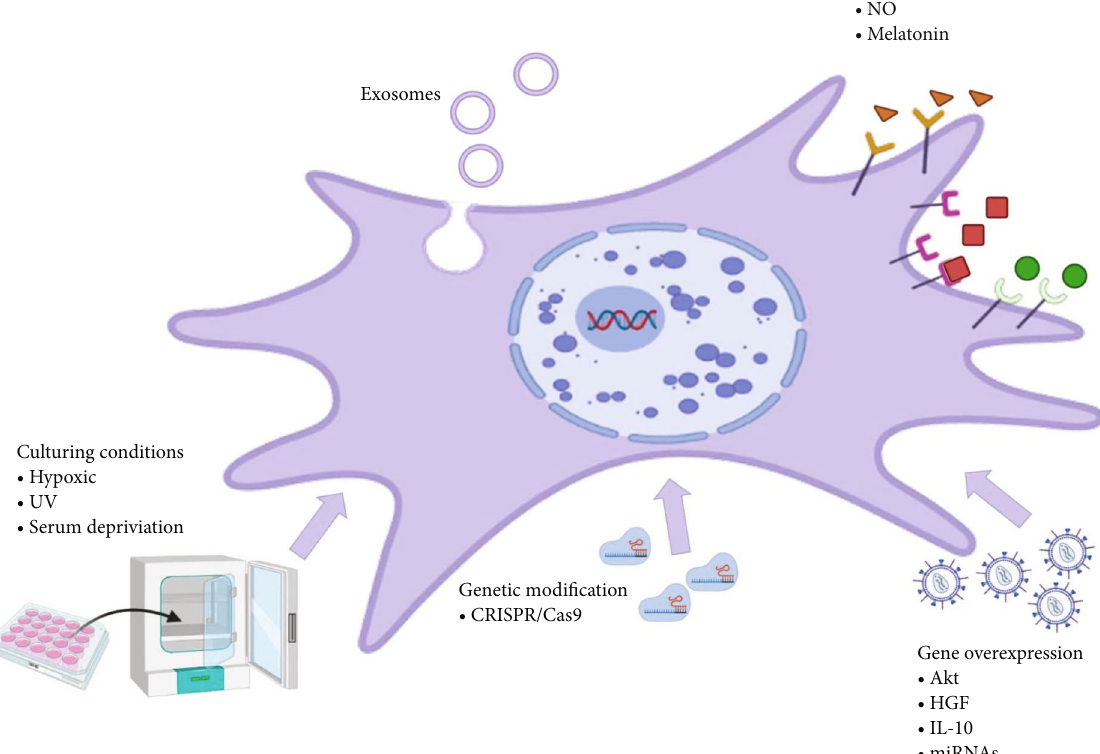
Figure 6: Preconditioning approaches to enhance the secretion and therapeutic e ffi cacy of exosomes. The yield of secretome can be increased by preconditioning strategies such as introducing hypoxic and serum deprivation culture conditions and genetic modi fi cation using CRISPR technology as well as overexpression of certain genes. LPS: lipopolysaccharides; NO: nitric oxide; IL: interleukin; miRNAs: micro RNAs; UV: ultraviolet (created with